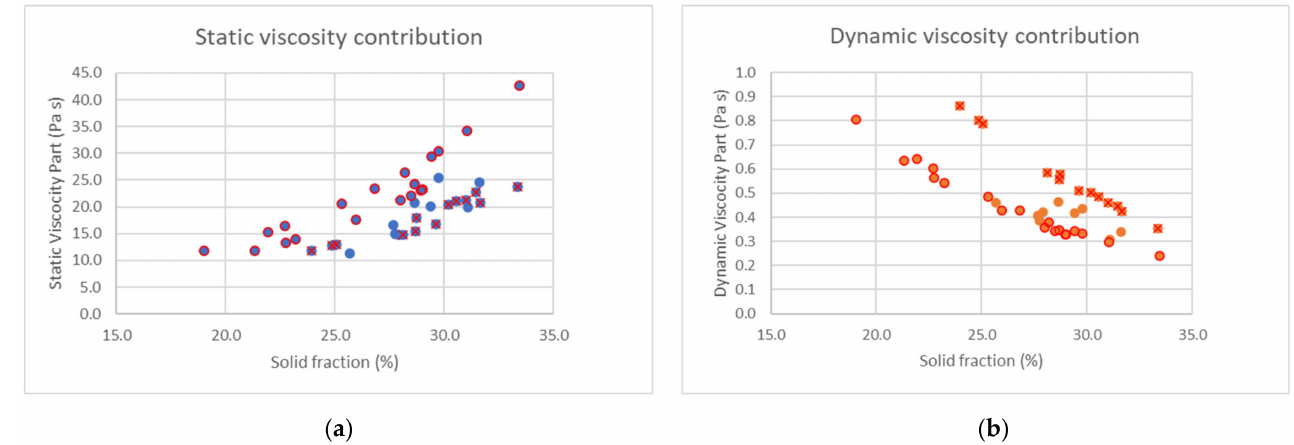
Figure 6. The relative contributions to the apparent viscosity from ( a ) static and ( b ) dynamic compo- nents in the Herschel–Bulkley model. The 20 kg shot weight dominates the higher range of static viscosity contribution (markers with a red circle) compared to the 2 kg shot samples (markers with the red cross). The higher dynamic contribution arises from the 2 kg shot weights (markers with a red cross), and the 20 kg shot dynamic contribution is shown with the red circled